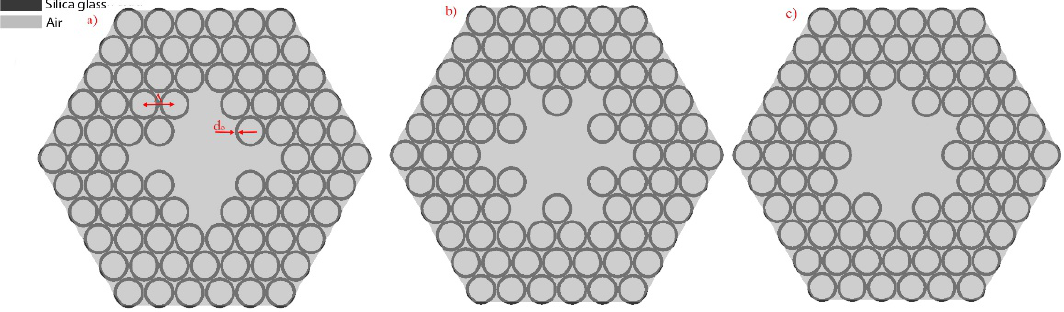
Figure 2. Modified hollow-core fiber structures, based on the 7-cell one ( a ) xy structure, ( b ) star structure, and ( c ) a-star structure.